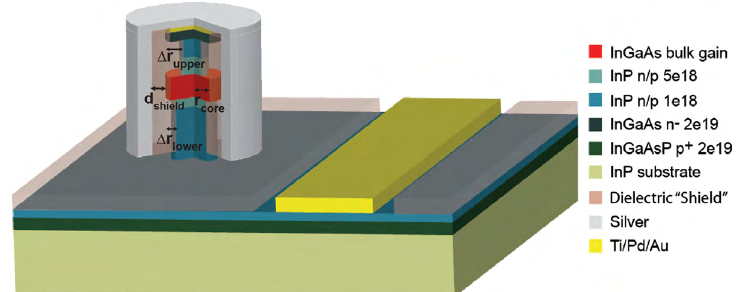
is the radius of InGaAs gain layer, Δ r core is the thickness of the shield shield